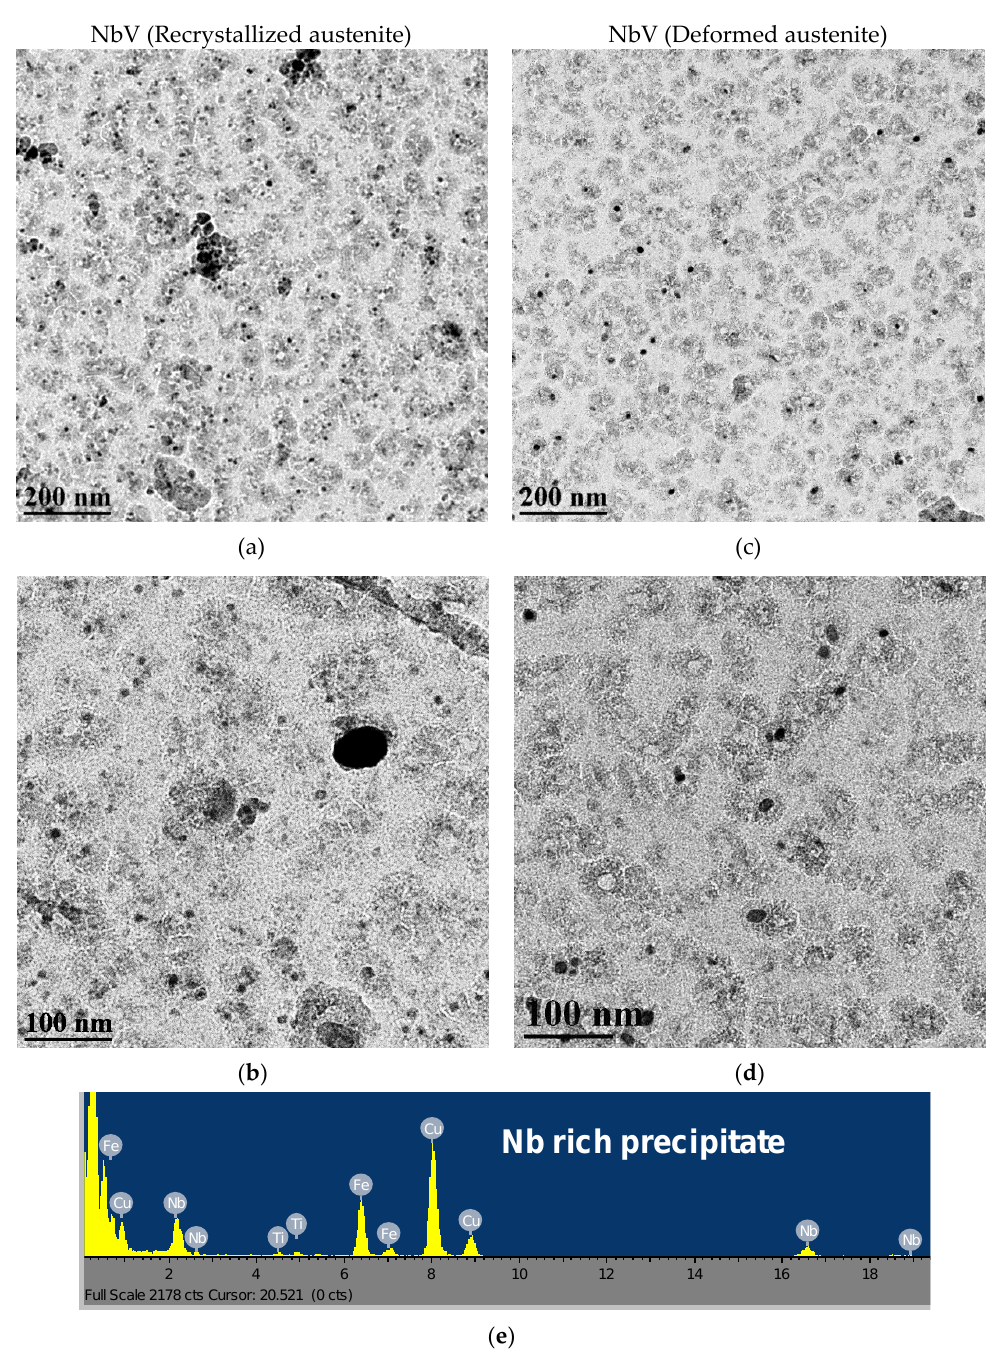
Figure 11. TEM images obtained in ( a , b ) NbV recrystallized austenite and ( c , d ) NbV deformed austenite at different magnifications for Tdef75. ( e ) Microanalysis of the precipitates.